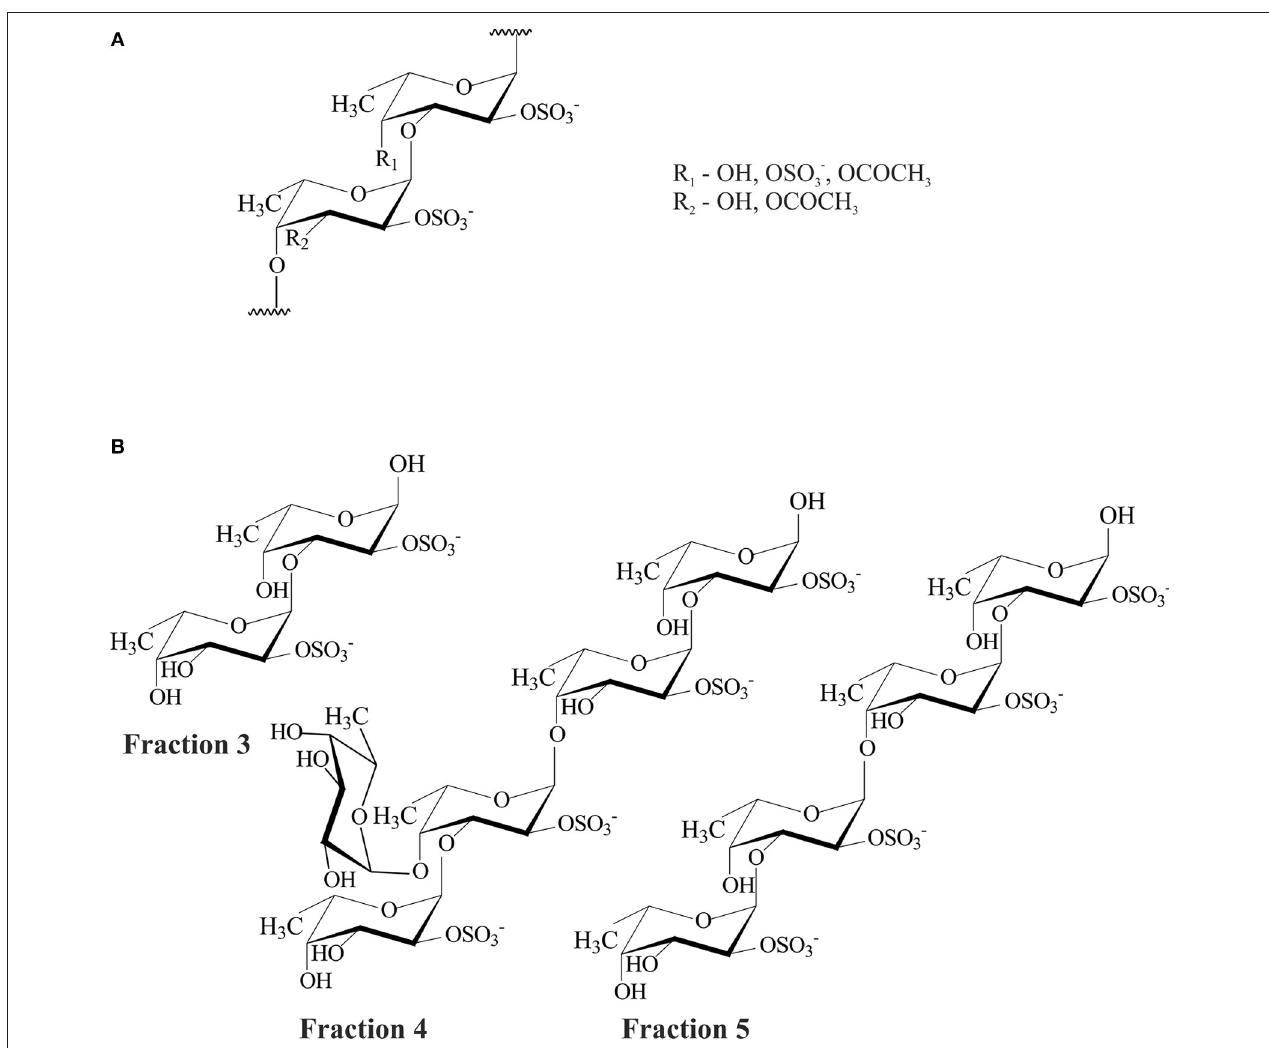
FIGURE 1 | Structures of fucoidan from F. evanescens (A) and products of its enzymatic hydrolysis (B).